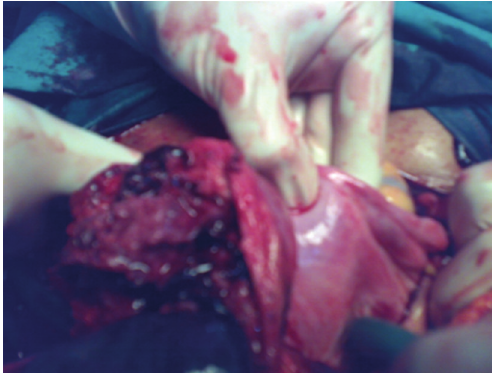
Figure 1: Rupture right rudimentary